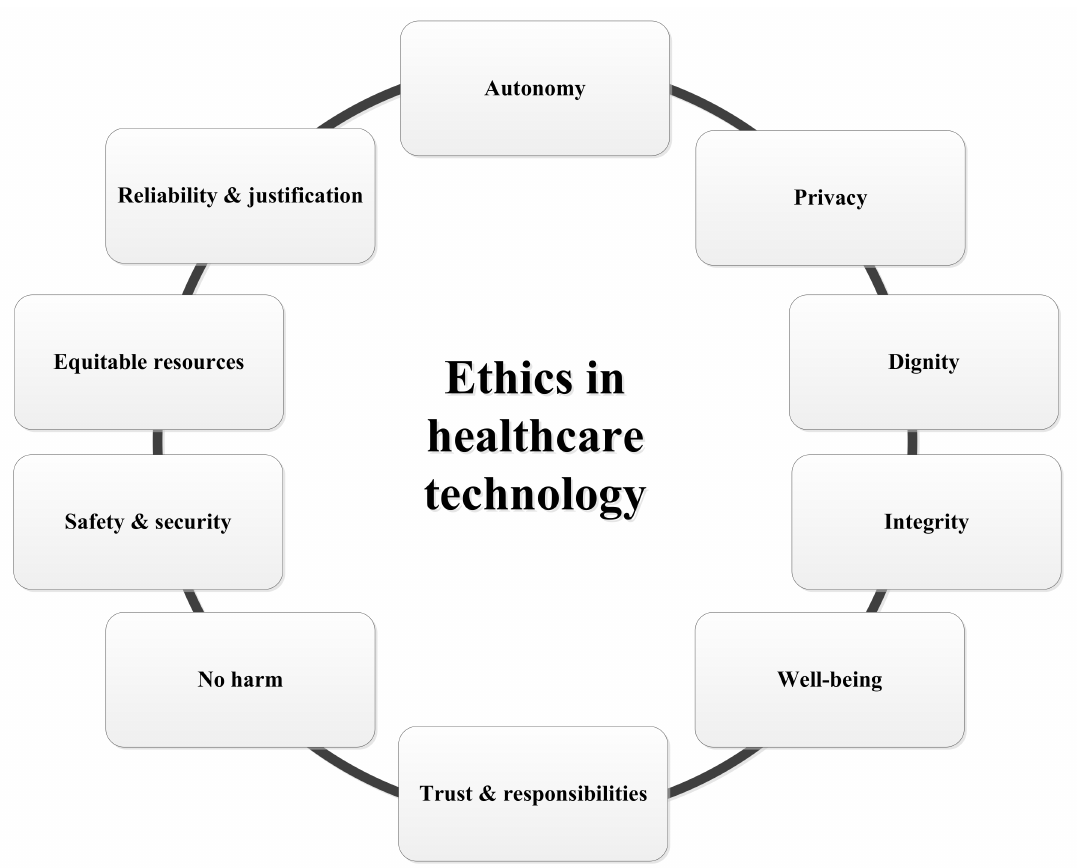
Figure 1. Ethics in healthcare